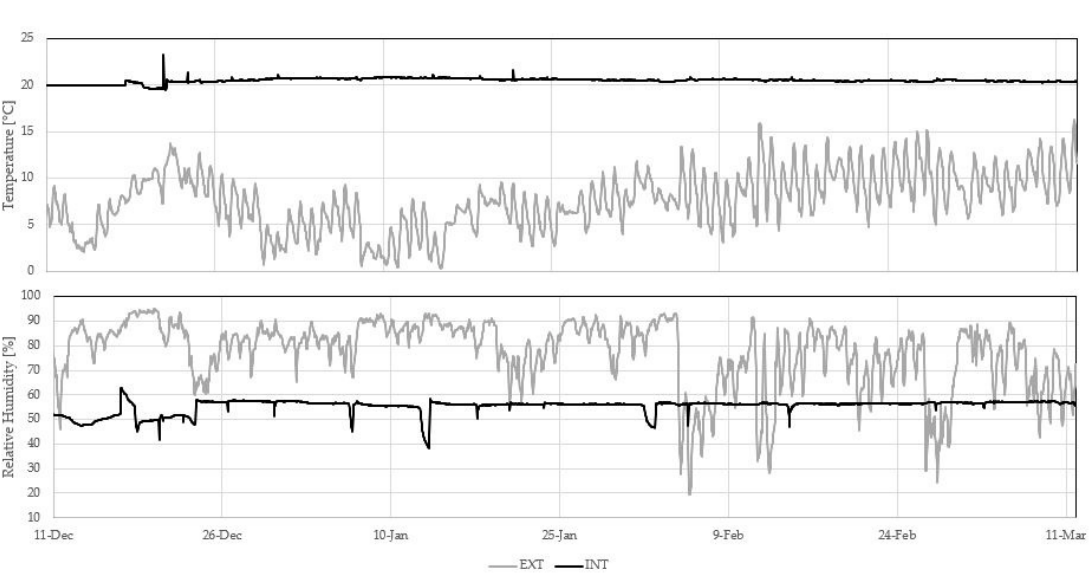
Figure 8. Hourly monitored data between 11 December 2019 and 11 March 2020, for external and internal climate: temperature (top panel) and relative humidity (bottom panel).